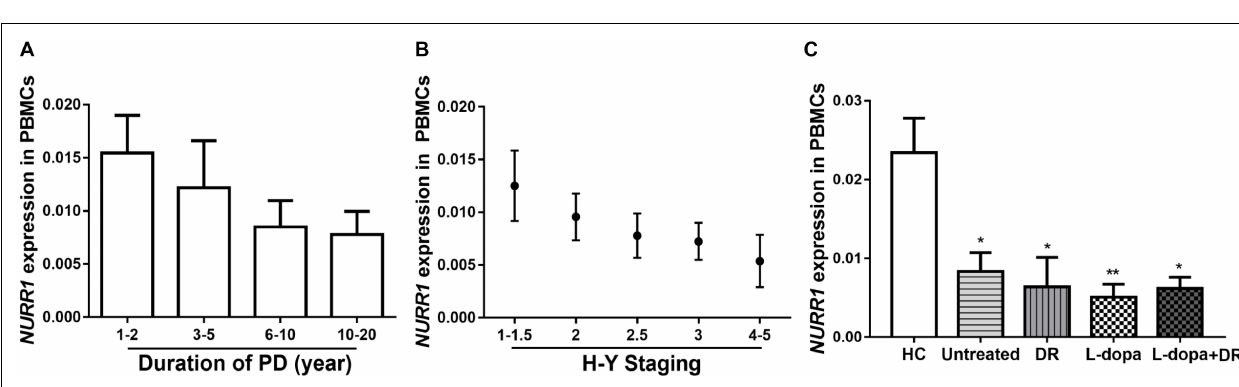
were treated with anti-PD medications, including 89 were treated with l-dopa monotherapy, 28 treated with DA receptor agonists (DR) monotherapy, and other 113 patients were treated with the combination of DA agonists and l-dopa. All these four groups were significantly lower expression level of NURR1 than HC, but there was no significant difference among the four groups ( Figure 2C ).